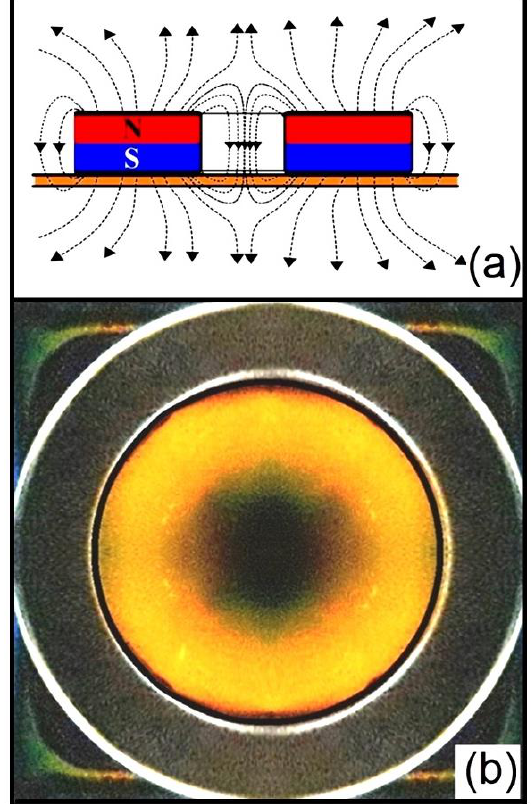
Figure 7. Diagram of the magnetic ring with field lines on the Ferrocell ( a ). Image of the experiment in ( b ) taking as its input the light circularly polarized to the left and analyzed with a polarizer to the right.